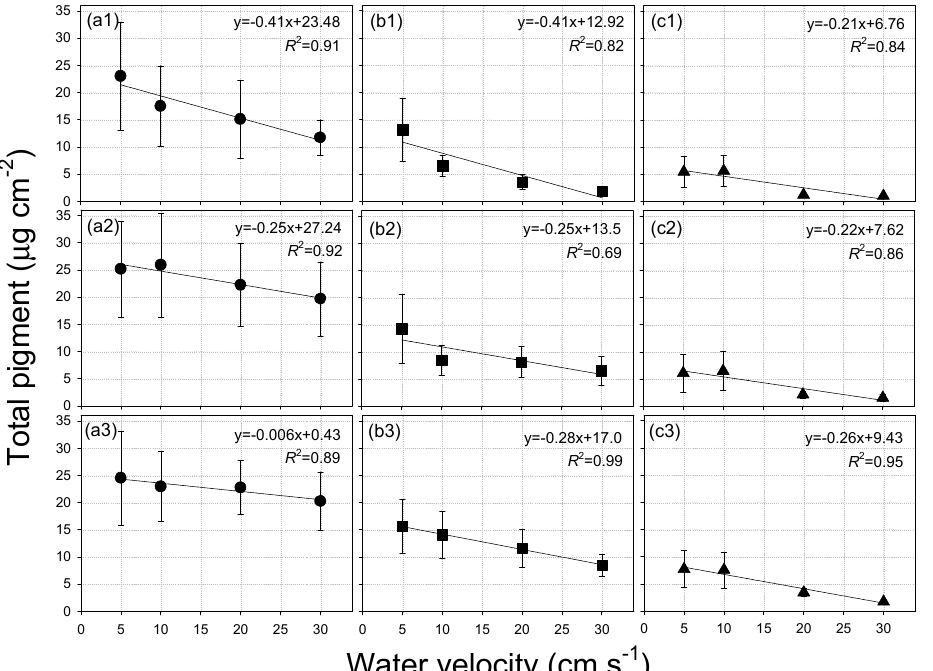
Figure 5 Relationships between water velocity and periphyton biomass with different water sources and substrata ( a ): MW1; ( b ): HR; ( c ): BFW; ( 1 : tile; 2 : concrete; 3 : pebble; n =